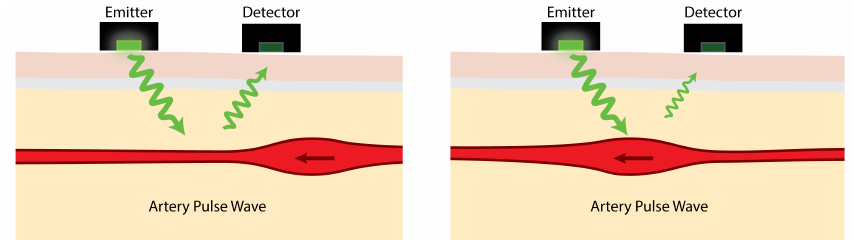
Figure 1. Light reflectance in photoplethysmography (PPG)